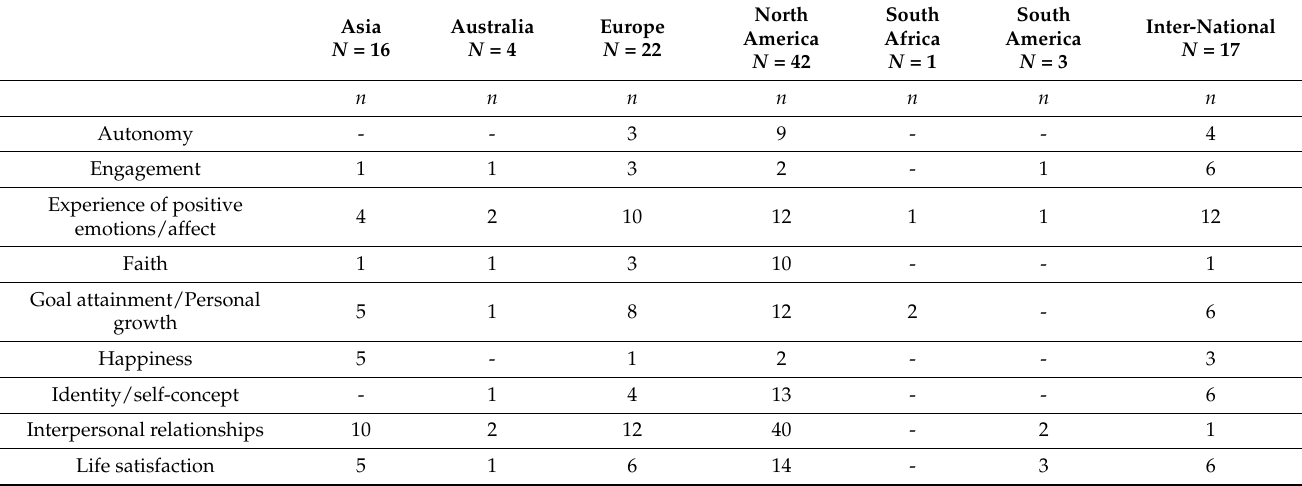
Table 4. Distribution of positive mental health concepts by region were studies were